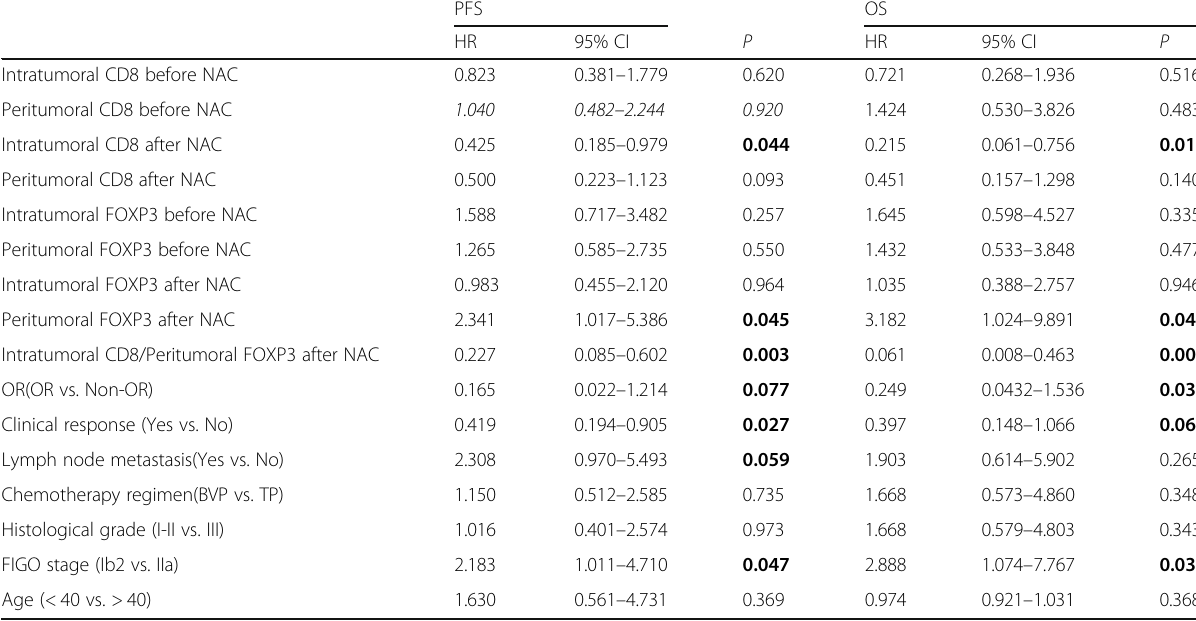
Table 2 Univariate analysis of clinical parameters and TILs for cervical cancer survival after NAC PFS OS HR 95% CI P HR 95%